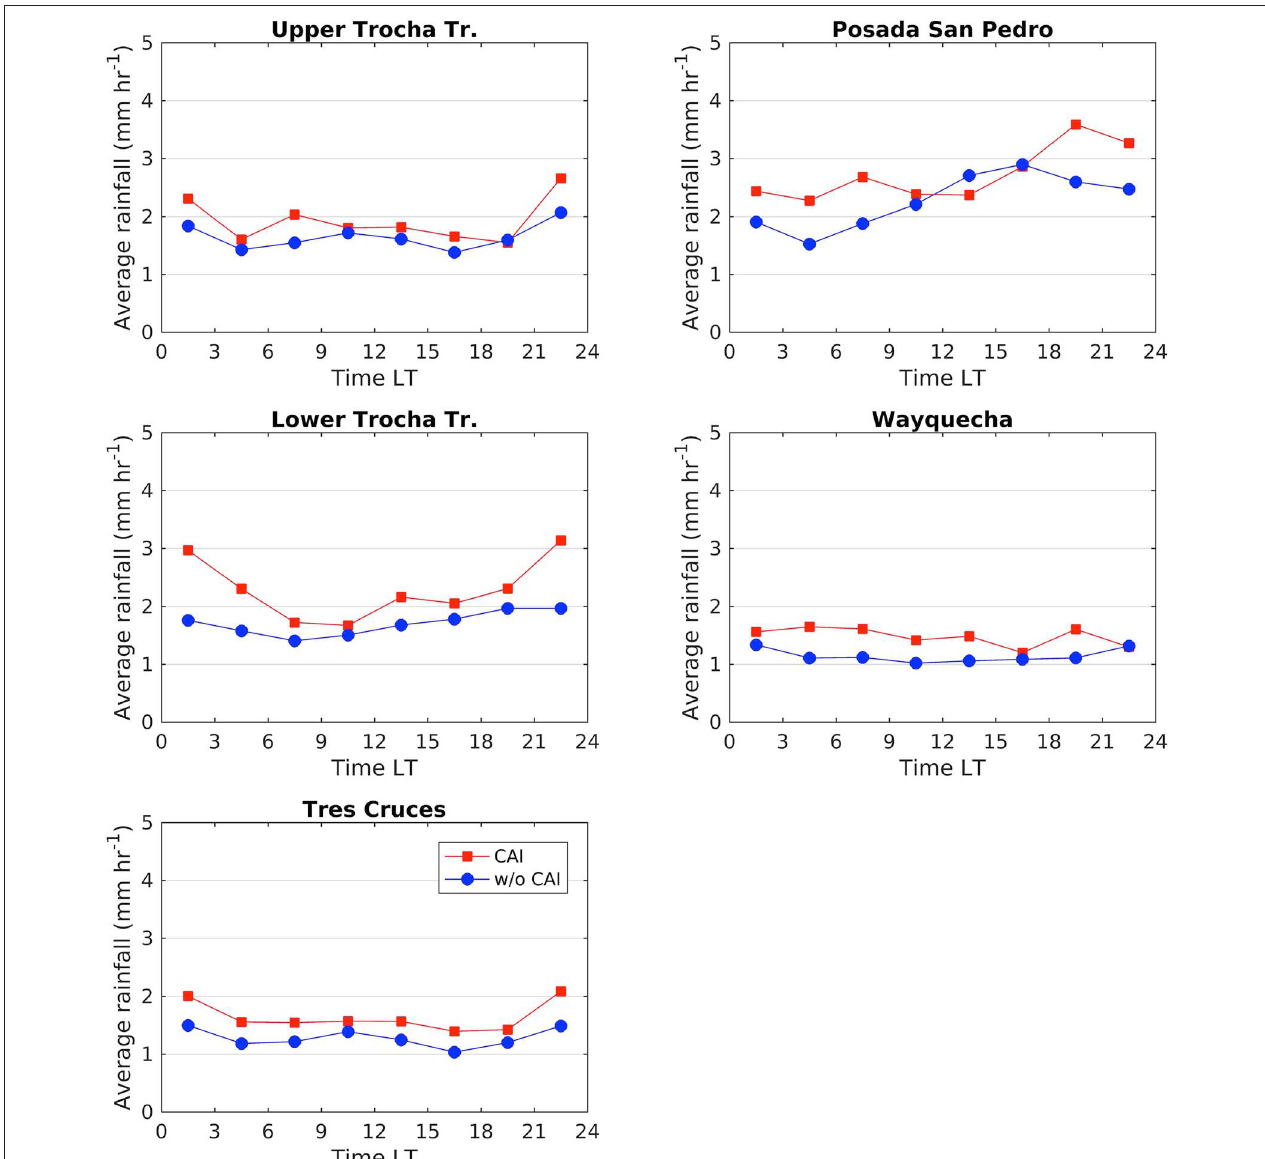
FIGURE 14 | Diurnal cycle of mean rainfall intensity from five gauges in the Madre de Dios network from April 2012–2017. Mean value calculations do not include times without rain. Circles show non-CAI climatology and squares show the mean values between 1 day before and after the detected CAI